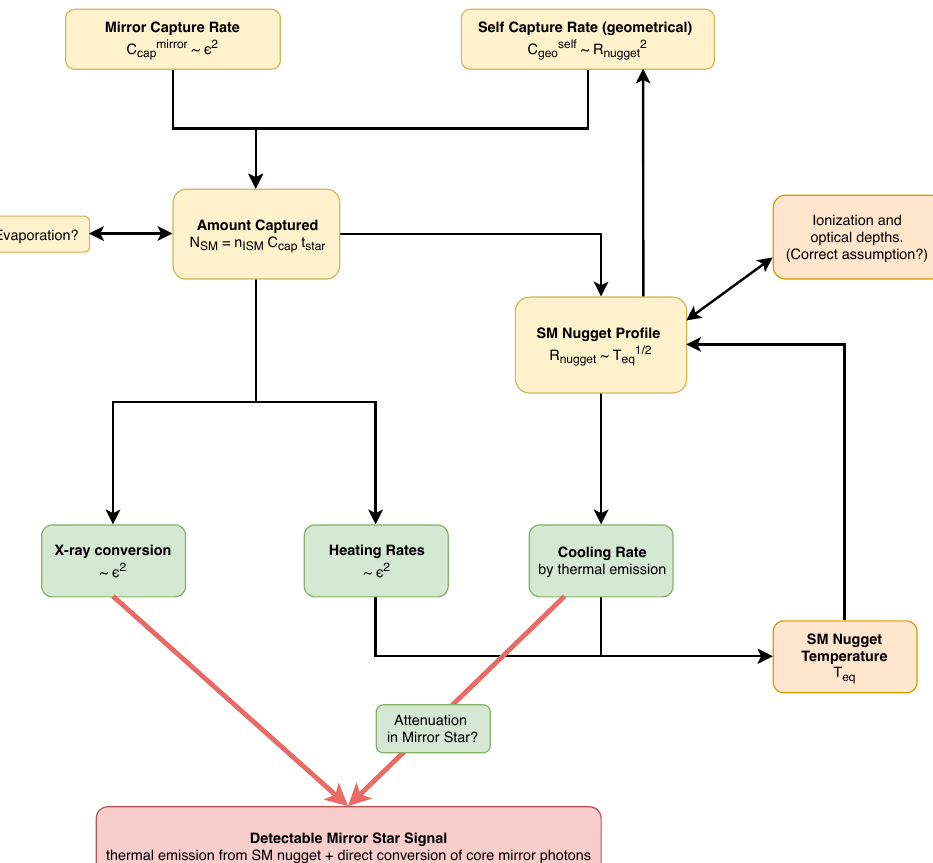
Figure 3 . Outline of computation of Mirror Star signal, assuming we know the radial temperature, density and composition pro(cid:12)les of the Mirror Star. We also assume that the nugget is either optically thin or thick to thermal photons and check whether this is consistent with the obtained SM nugget pro(cid:12)le. The components in yellow are the focus of section 4, and determine the structure of the nugget (size and density) assuming that we know its equilibrium temperature. The components in green are the focus of section 5, in which we calculate the temperature of the nugget assuming we know its structure. Thus the results of sections 4 and 5 together allow a consistent solution for all of the nugget’s properties. Once the structure is obtained the calculation of the signal is shown in section